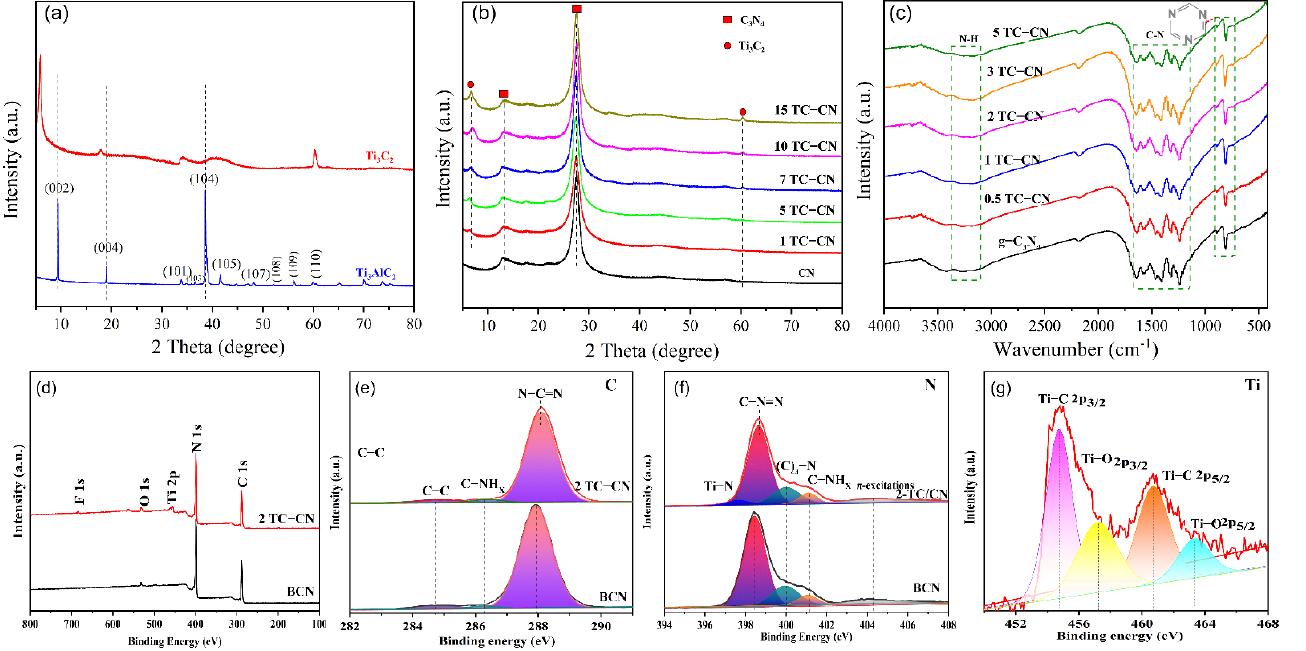
Figure 3. ( a ) XRD patterns of Ti 3 AlC 2 and Ti 3 C 2 , ( b ) XRD patterns of g − C 3 N 4 and TC/CN, ( c ) FTIR spectra of g − C 3 N 4 and TC/CN, ( d ) XPS survey of g − C 3 N 4 and 2 − TC/CN, ( e ) high − resolution XPS spectra of C1s, ( f ) high − resolution XPS of N1s, ( g ) high − resolution XPS of Ti 2p.